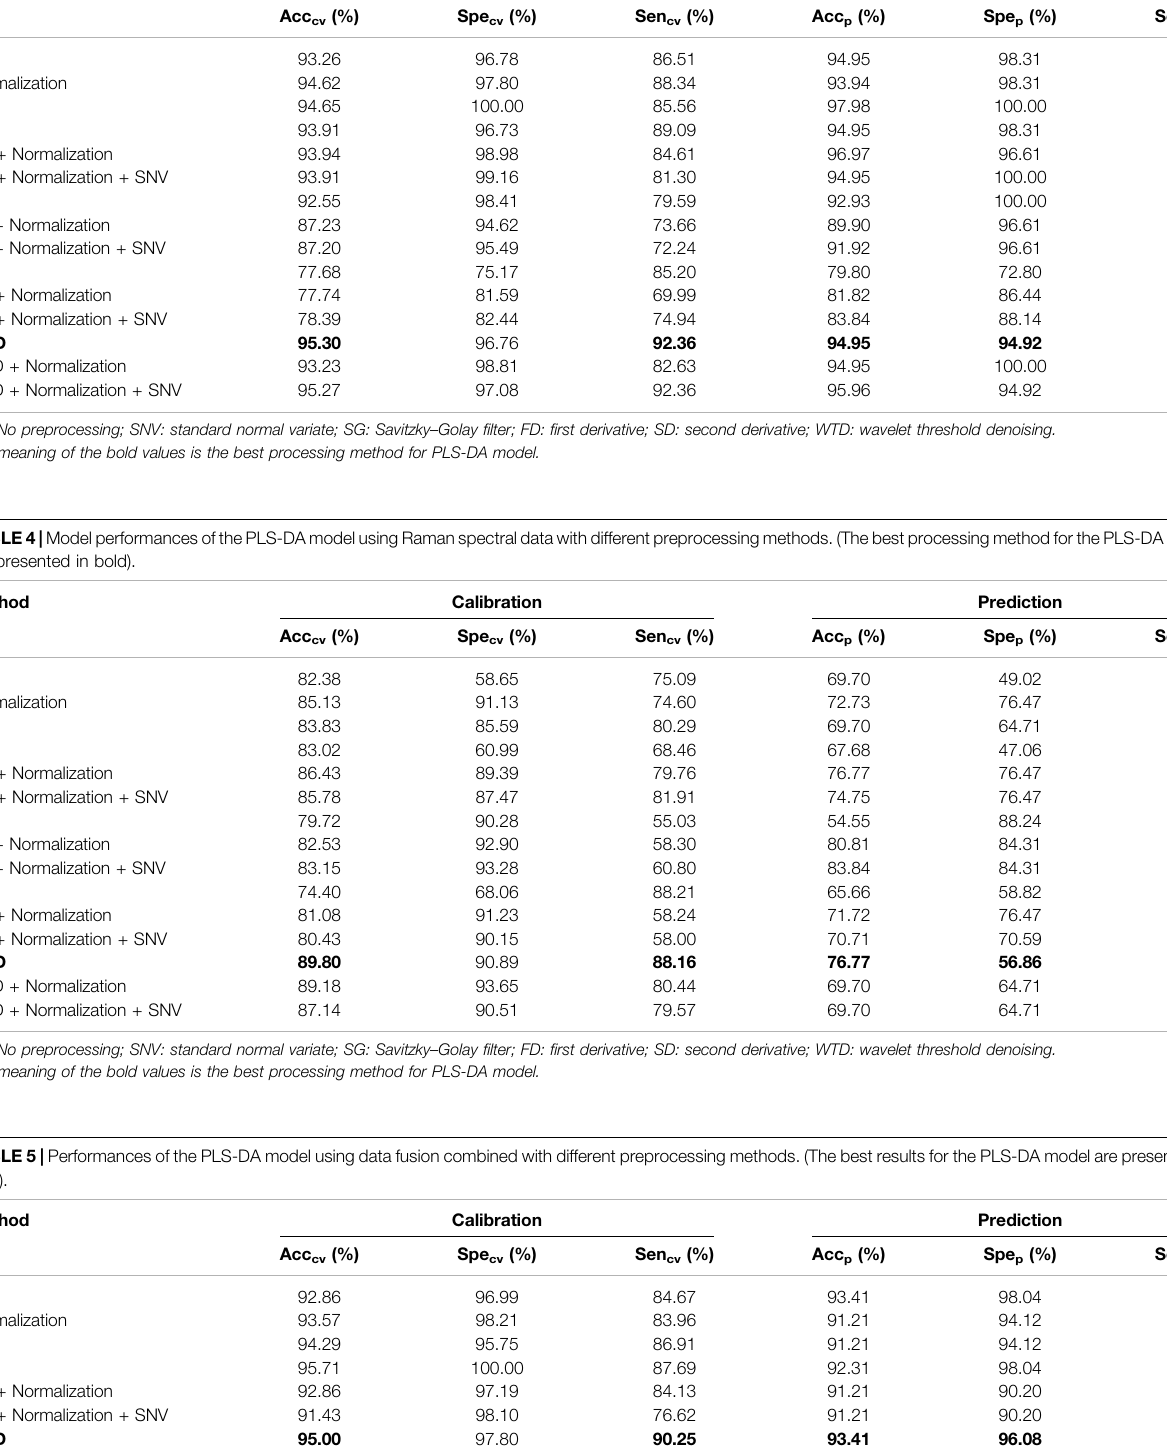
TABLE 3 | Model performances of the PLS-DA model using FTIR spectral data with different preprocessing methods. (The best processing method for the PLS-DA model are presented in bold). Method